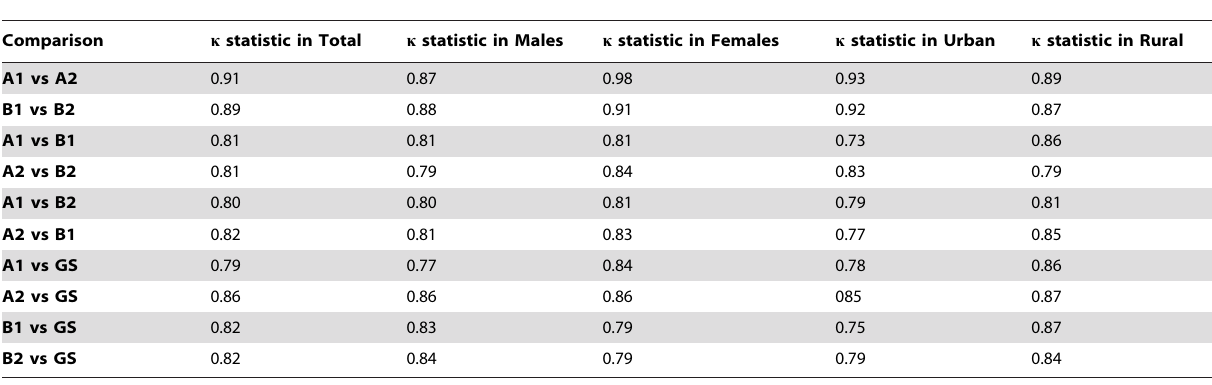
Table 2. Kappa ( k ) statistics for reliability and validity testing of VA interview in 149 documented deaths.